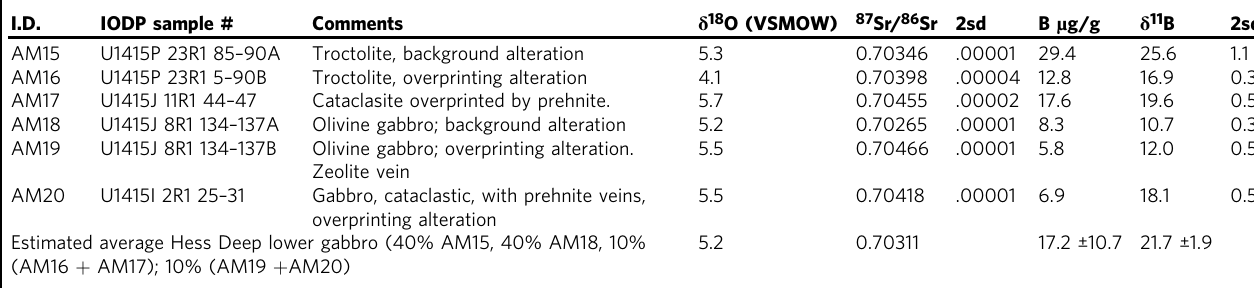
Table 1 Samples and data I.D.